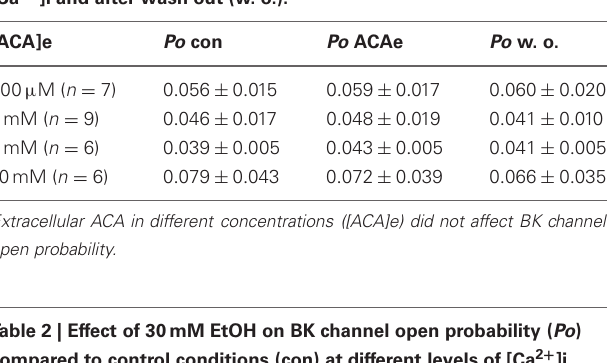
Table 1 | Effect of extracellular ACA (ACAe) on BK channel open probability ( Po ) compared to control conditions (con) at 1.2 μ M [Ca 2 + ]i and after wash out (w. o.).